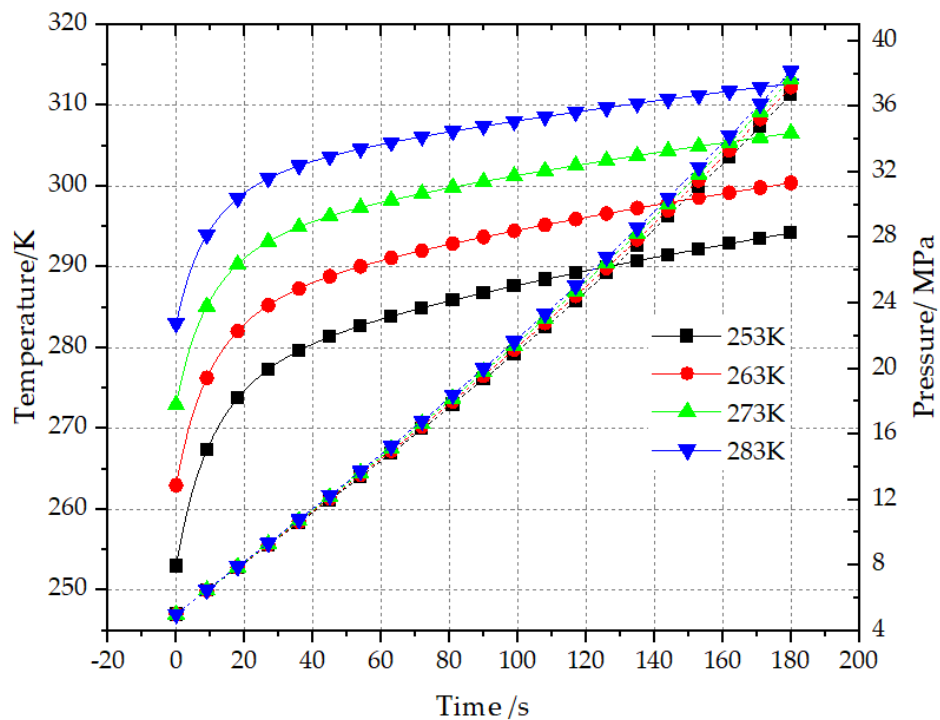
Figure 9. Effect of ambient temperature on temperature and pressure revolution.